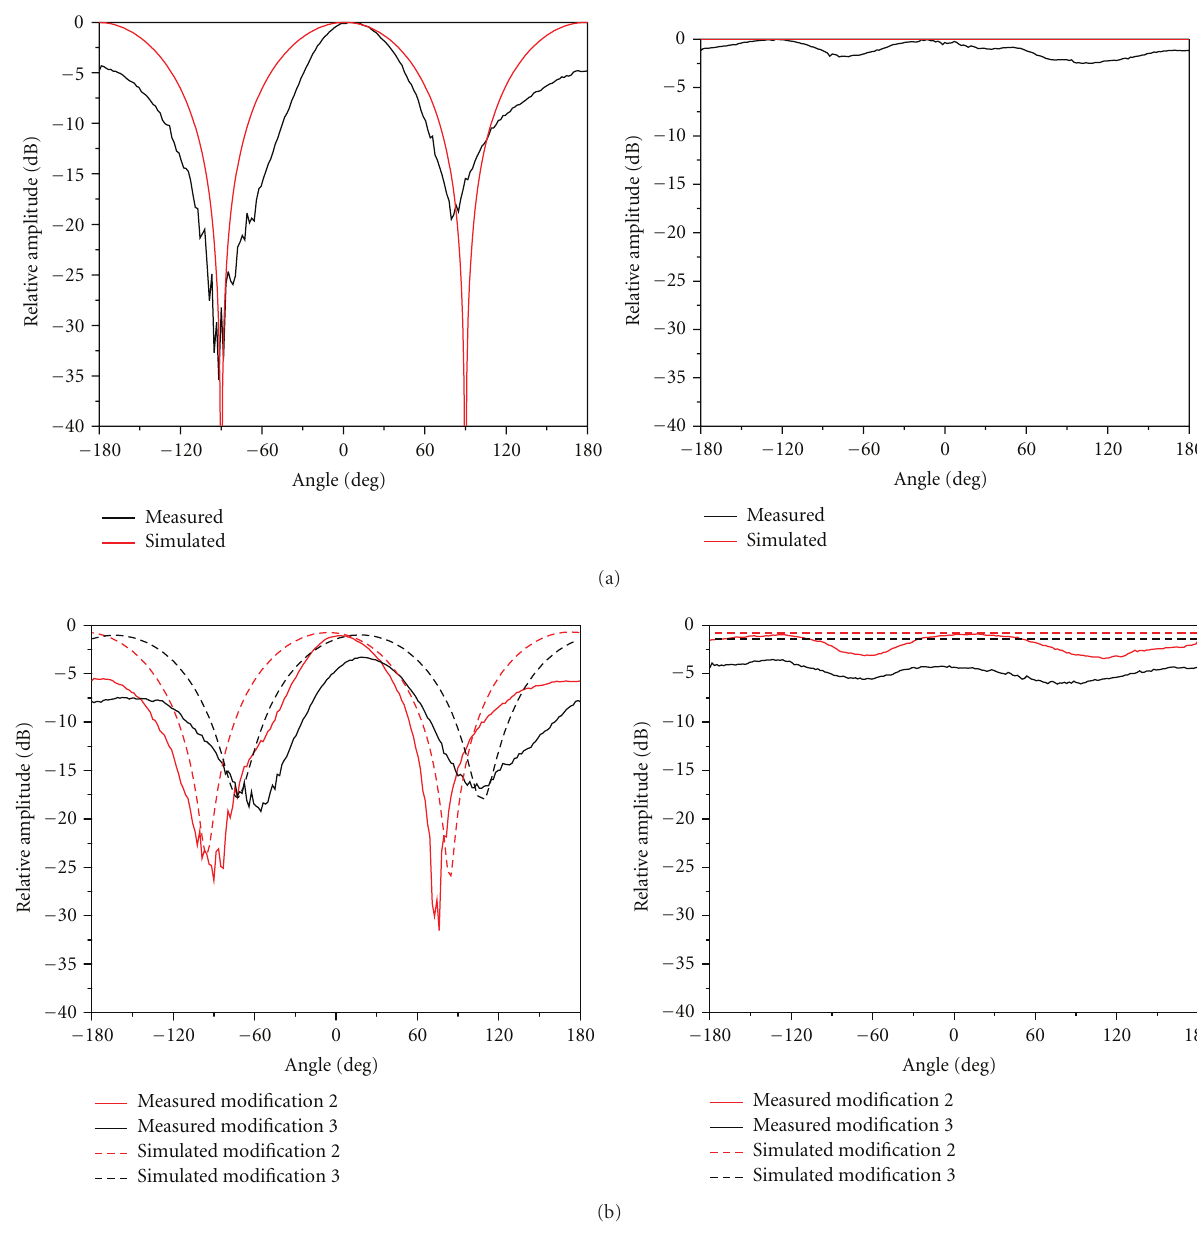
Figure 8: Comparison of simulated and measured radiations patterns in E-plane and H-plane for: (a) the planar fractal antenna and (b) modification 2 and modification 3 of the fractal